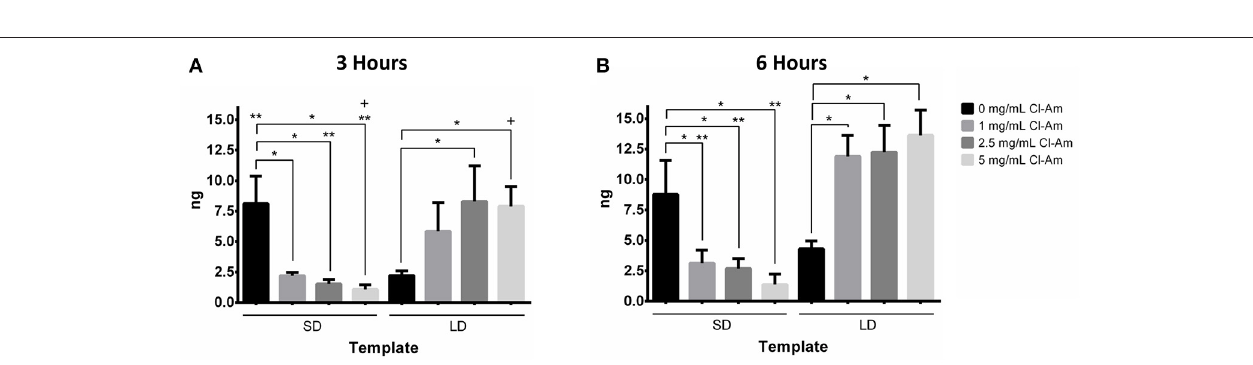
FIGURE 7 | Cl-Am significantly decreases NETosis on SD templates. The BG ratio for templates at (A) 3 and (B) 6h indicate that template architecture modulates NETosis. In addition, the elution of Cl-Am significantly affects NETosis at 3h with minimal effects at 6h. *Significant difference ( p < 0.05). + Significant difference between 3 and 6h ( p < 0.05) (mean ± std. dev., n = 4).